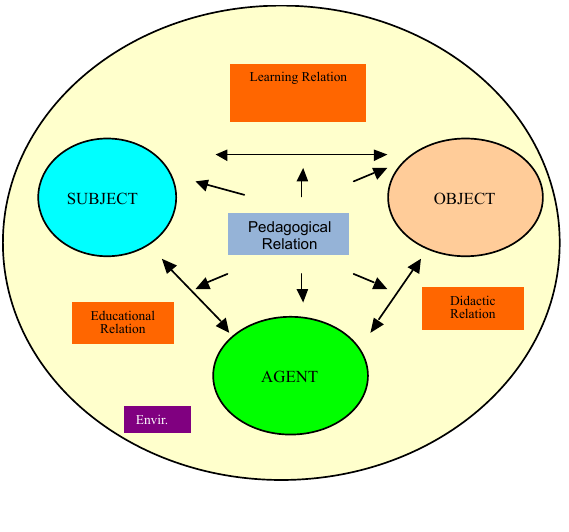
1 | Fig. 1: Pedagogical Relationship Model (Renald Legen- dre, 1993;